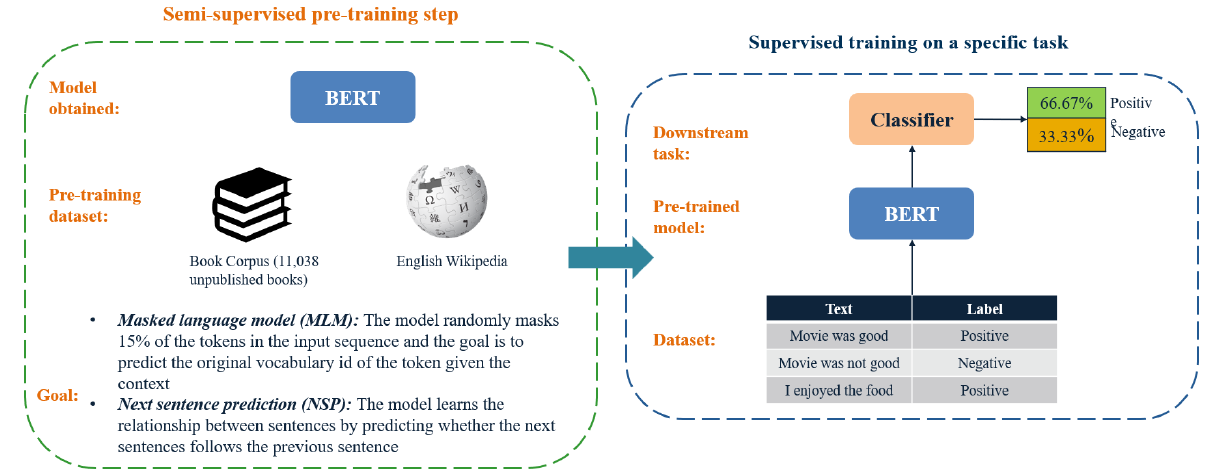
Figure 3. Fine-tuning a BERT language model on a text classification task